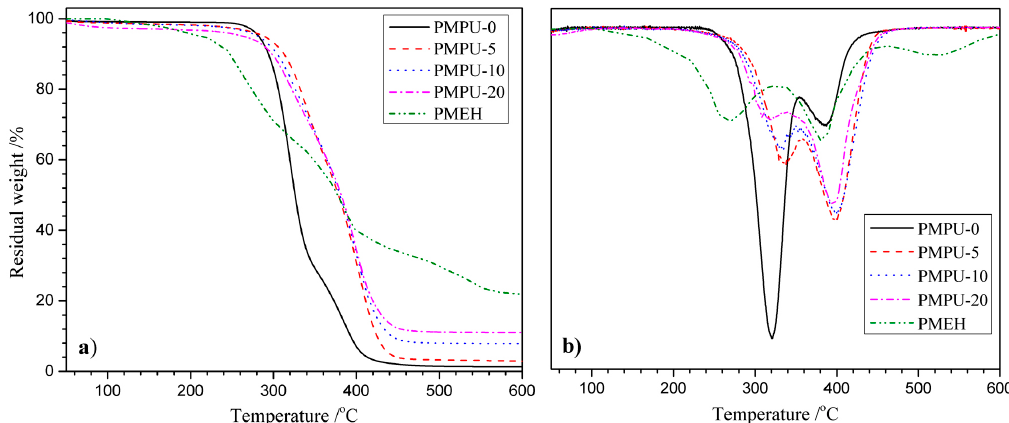
Figure 1. ( a ) Thermogravimetric analysis (TGA) and ( b ) differential gravimetric thermal analysis (DTGA) curves of composite films with varying PMEH content.